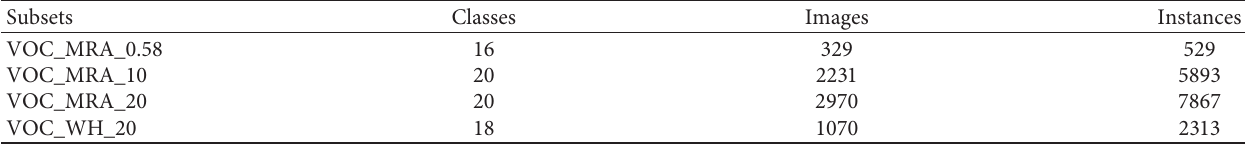
Table 1: The information of the subsets.